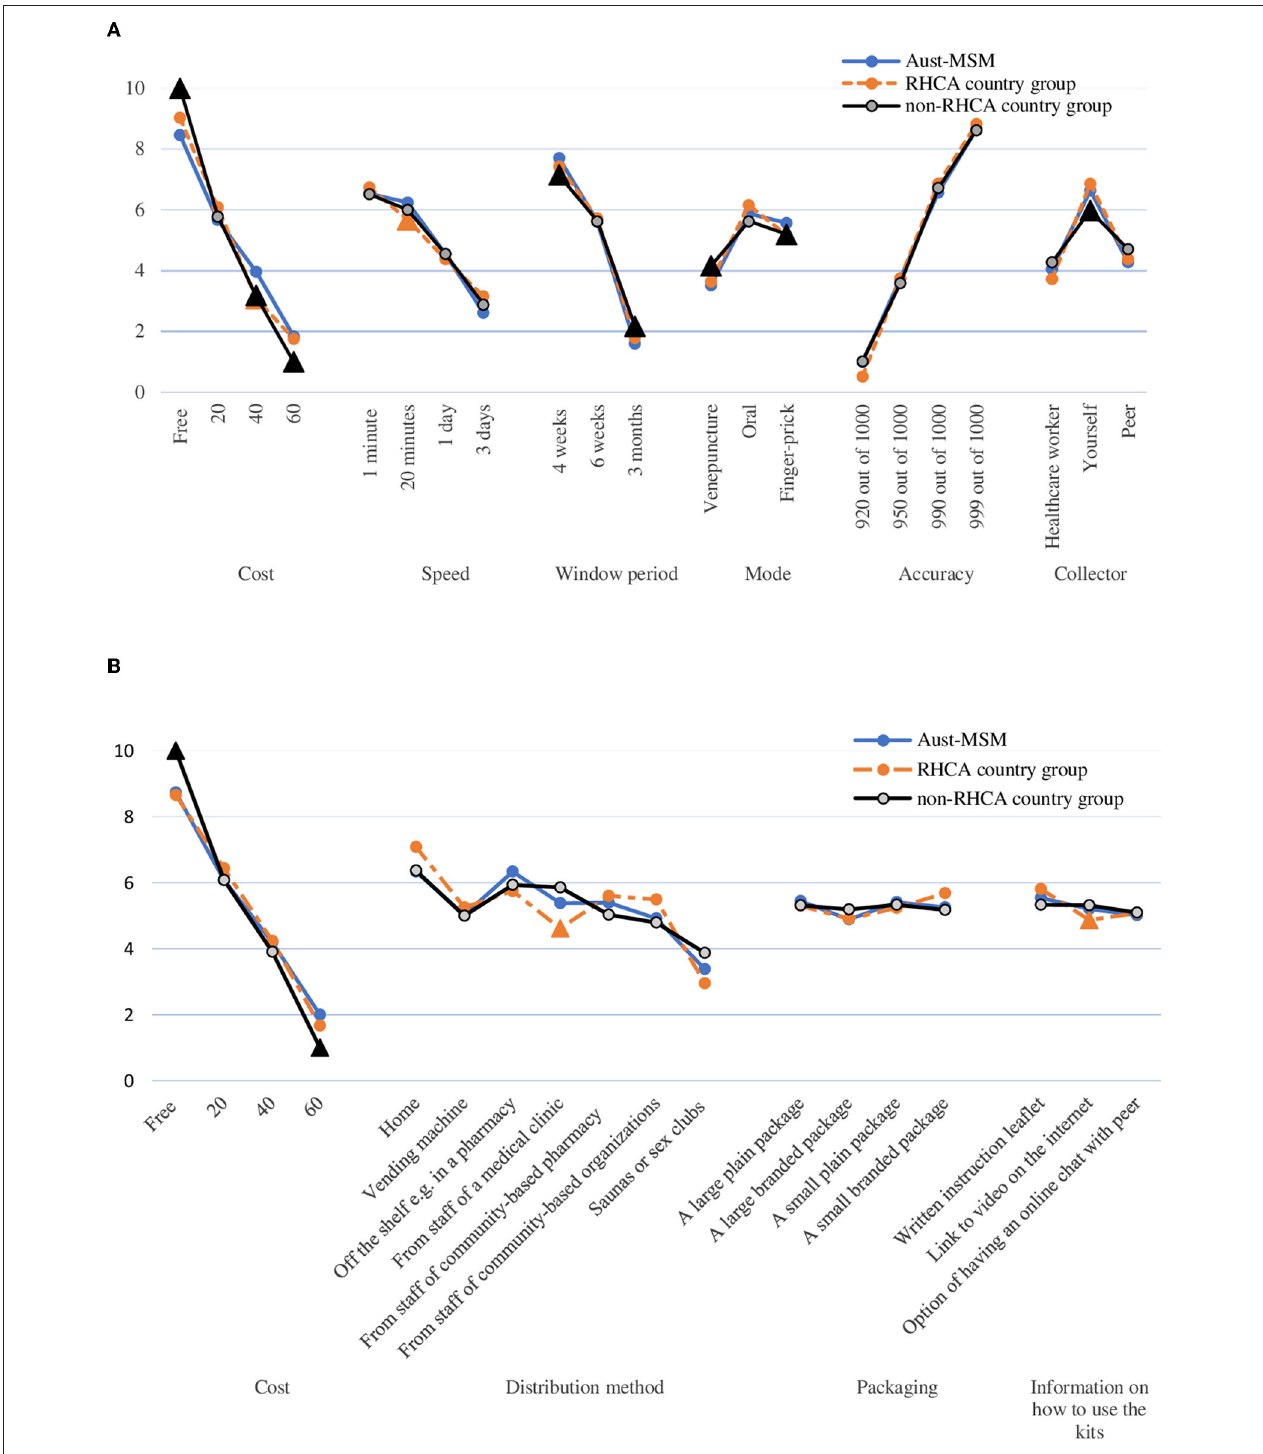
FIGURE 3 | Scales estimated of HIV testing and HIV self-testing attributes among Aust-MSM, RHCA country group and non-RHCA country group. (A) Scaled estimates of HIV testing preferences, by country of birth. (B) Scaled estimates of HIV self-testing distribution preferences, by country of birth. Note: Triangle denotes estimate is statistically significantly different from the mean preference of